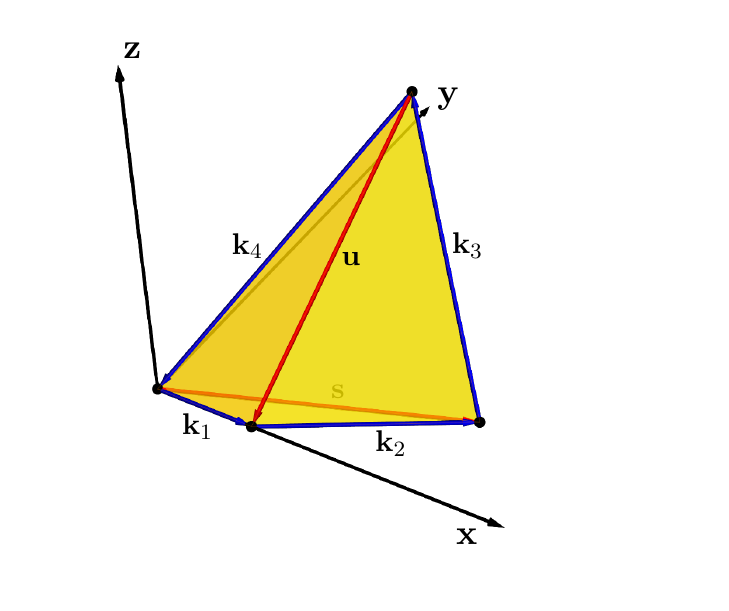
Figure 1 . Tetrahedron configuration (2.20) for the normalization condition and definition of τ PO NL